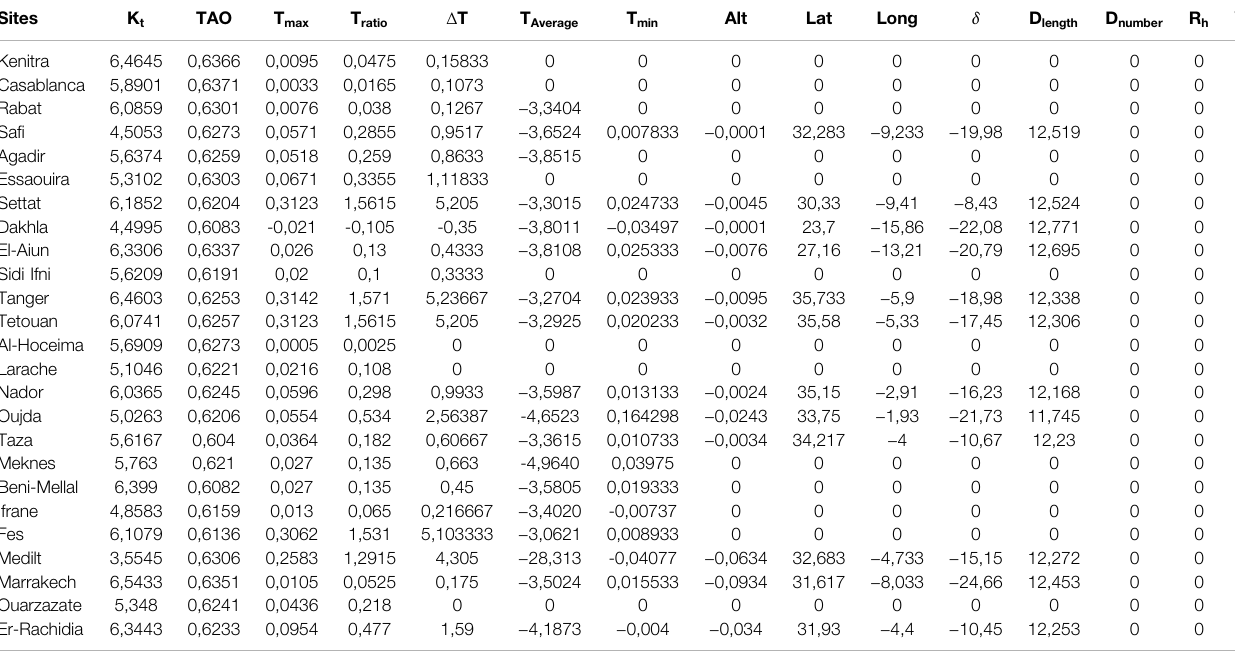
TABLE A1 | Linear relationship for best input of 25